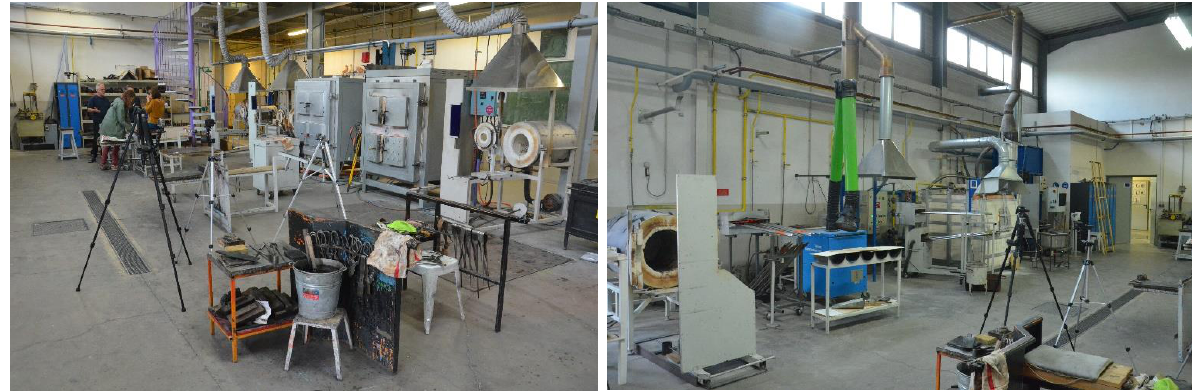
Figure 12. Documentation on the arrangement of machinery items at the CERFAV workshop.